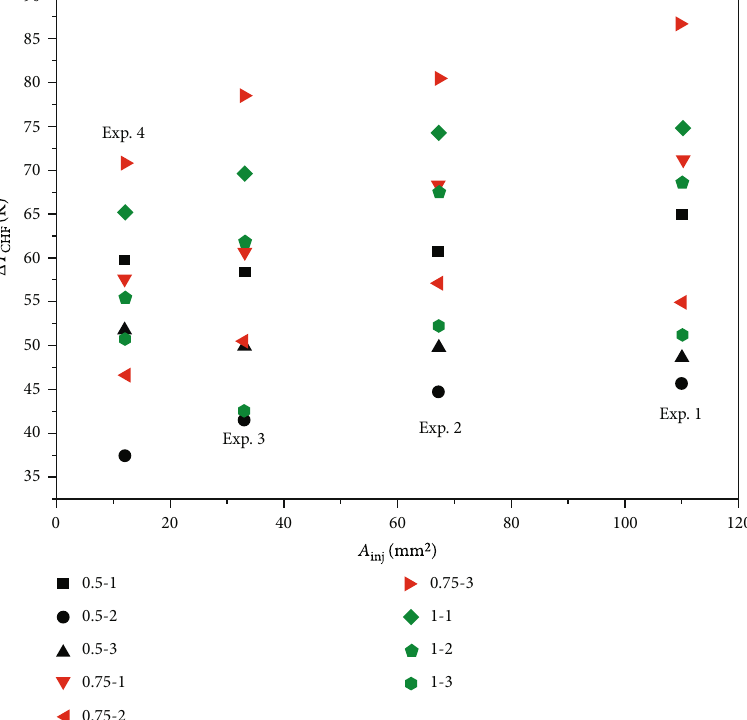
CHF versus A inj